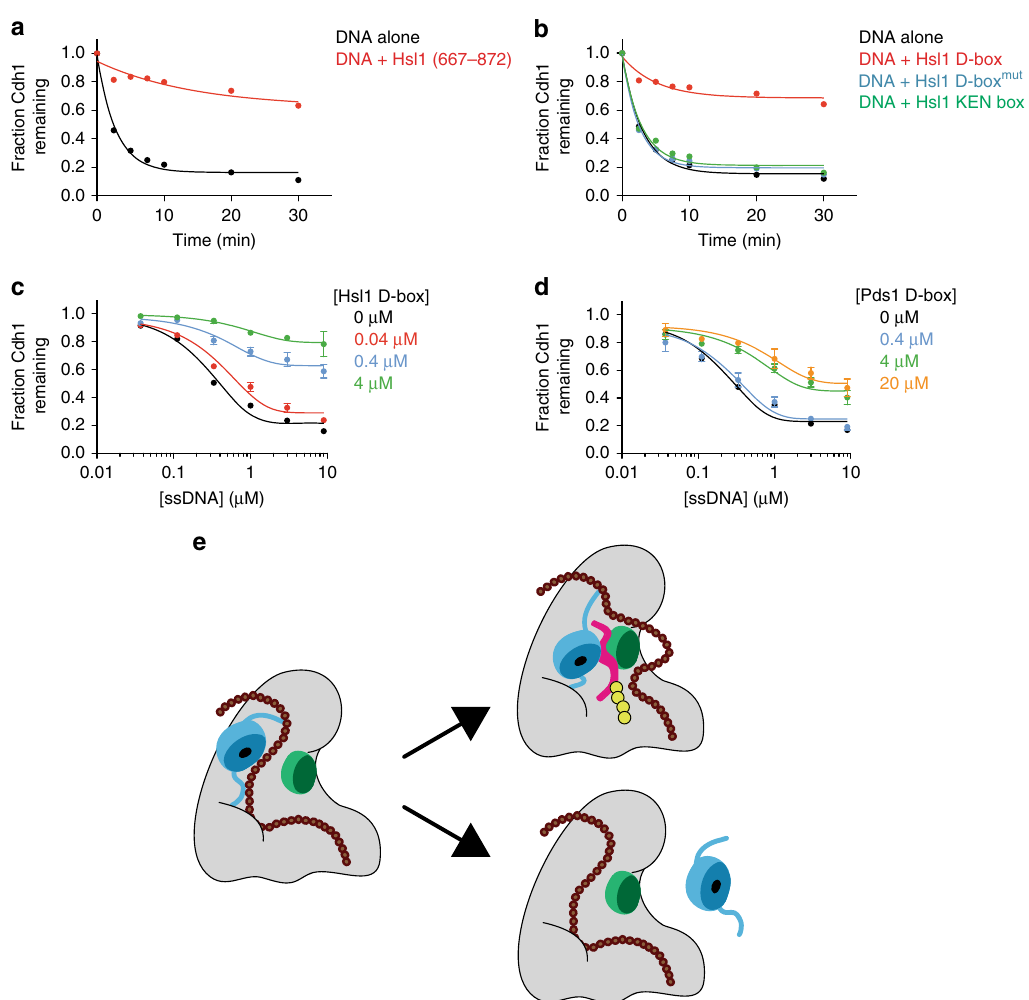
Fig. 6 D box-dependent substrate binding protects activator from dissociation. a Cdh1 dissociation was measured with 1.5 μ M 75-base ssDNA and 3 mM ATP, in the absence (black) or presence (red) of 4 μ M puri fi ed Hsl1 fragment (aa 667 – 872). Uncropped autoradiographs and source data are provided in the Source Data fi le. b Cdh1 dissociation was measured in the presence of buffer (black), 4 μ M Hsl1 D box peptide (red), Hsl1 D box peptide mutant (blue), or Hsl1 KEN box peptide (green). Reactions were performed in the presence of 1.5 μ M 75mer ssDNA and 3 mM ATP. Uncropped autoradiographs and source data are provided in the Source Data fi le. c , d Cdh1 dissociation was measured in the presence of different concentrations of 75 mer ssDNA and D box peptides from c Hsl1 or d Pds1 (black 0 μ M, red 0.04 μ M, blue 0.4 μ M, green 4 μ M, orange 20 μ M). Reactions were supplemented with 3 mM ATP. Data indicate means (±SEM) from two independent experiments. Uncropped autoradiographs and source data are provided in the Source Data fi le. e Model for dynamic regulation of APC/C activity by polyanions. Activator (blue) binding to the APC/C is mediated by binding motifs located on fl exible N- and C-termini. Long polyanionic molecules (brown) interact at multiple sites on the APC/C, perhaps disrupting interactions between the activator termini and the APC/C. We speculate that one part of the polyanion chain interferes with productive substrate D box binding by pushing the activator WD40 domain away from Apc10 (green) and/or by directly interacting with Apc10. A high-af fi nity D box (red) overcomes this interference and links activator to Apc10, thereby promoting activator binding and substrate ubiquitylation